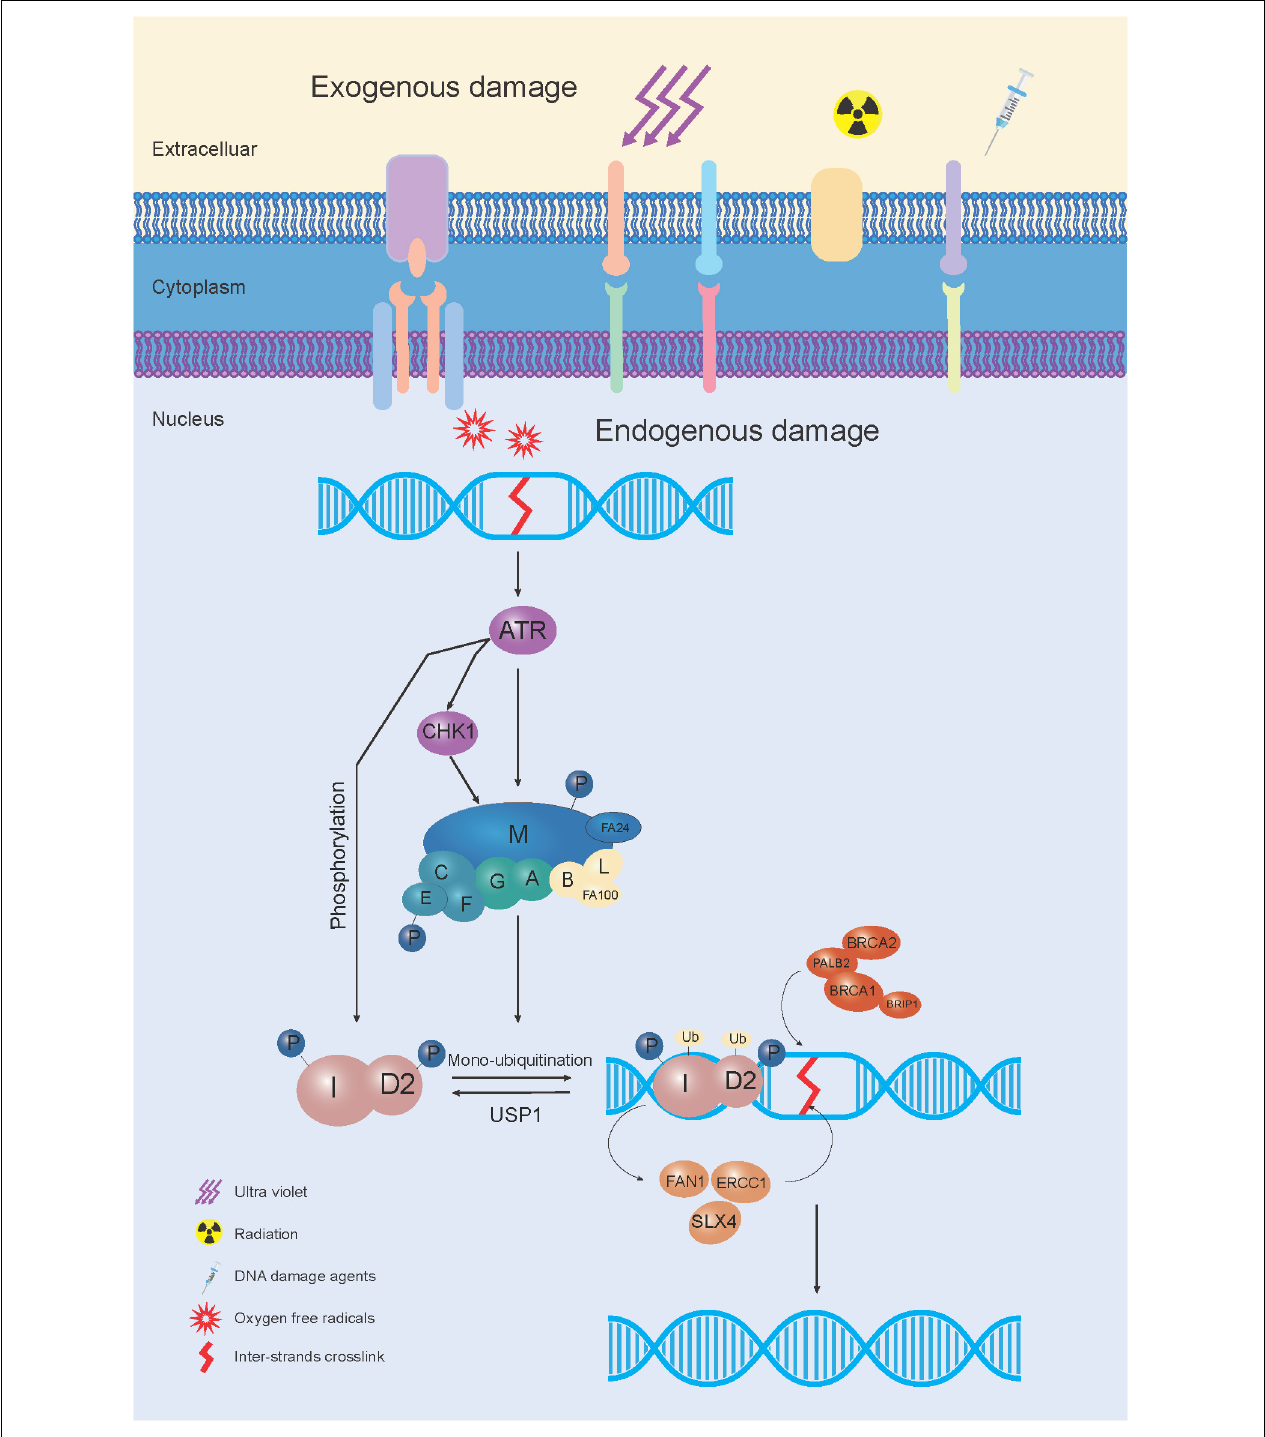
FIGURE 1 | The schematic elucidation of the FA pathway mechanism used during DNA repair. In response to exogenous and/or endogenous damage, 8 FA genes ( FANCA , FANCB , FANCC , FANCE , FANCF , FANCG , FANCL , and FANCM ) were assembled into the FA core complex, which functioned as a nuclear E3 ubiquitin ligase complex, to monoubiquitinate the I-D heterodimer. The monoubiquitinated I-D heterodimer was localized to the damaged chromatin, and interacted with DNA-repair proteins and other FA proteins (FANCD1, FANCDN, FANCJ, and FANCS) in the FA pathway, to conduct the repair process through homologous recombination (HR). After the damage was repaired, monoubiquitin was removed from the I-D complex by a de-ubiquitylation enzyme, Ubiquitin Specific Peptidase 1 (USP1), to “turn off” the network.